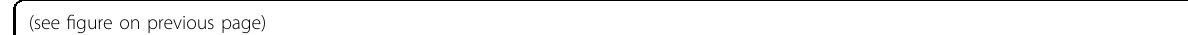
Fig. 6 XBP1s attenuates palmitate-induced insulin resistance in adipocytes. Adipocytes were transfected with control (EV) or pcDNA3.1-mXBP1s (XBP1s) and treated with vehicle or palmitate (200 μ M) for 24 h. Cells were further incubated with insulin (1 μ g ml − 1 , 30 min) as indicated, and then the following parameters of insulin resistance were determined (see Materials and methods): a Insulin signaling; b GLUT4 distribution; c glucose uptake rate; d , e Intracellular mRNA and secreted protein levels of adipokines such as adiponectin, leptin, MCP1, and TNF α ; f NF κ B and P-JNK expression; and g glycerol release rate. Values are presented as the means ± SEM of three independent experiments. * P < 0.05 compared to EV control. # P < 0.05 compared to palmitate control. & P < 0.05 compared to insulin-untreated and palmitate-untreated